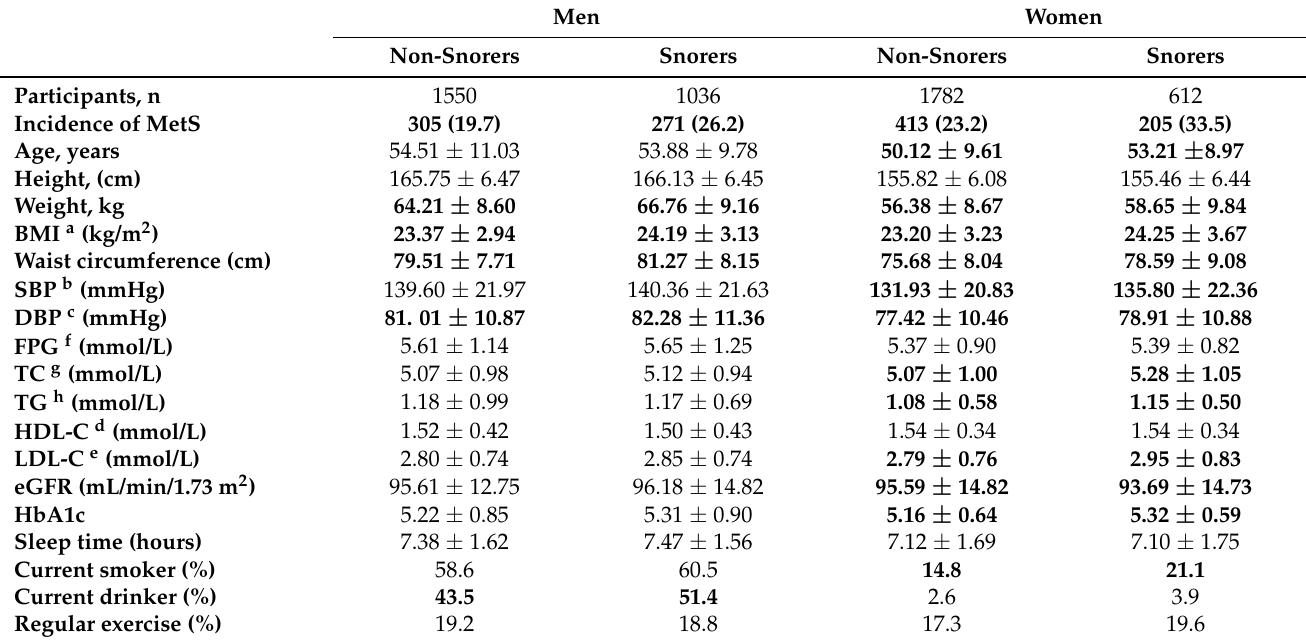
Table 1. Baseline characteristics of subjects with or without snoring i